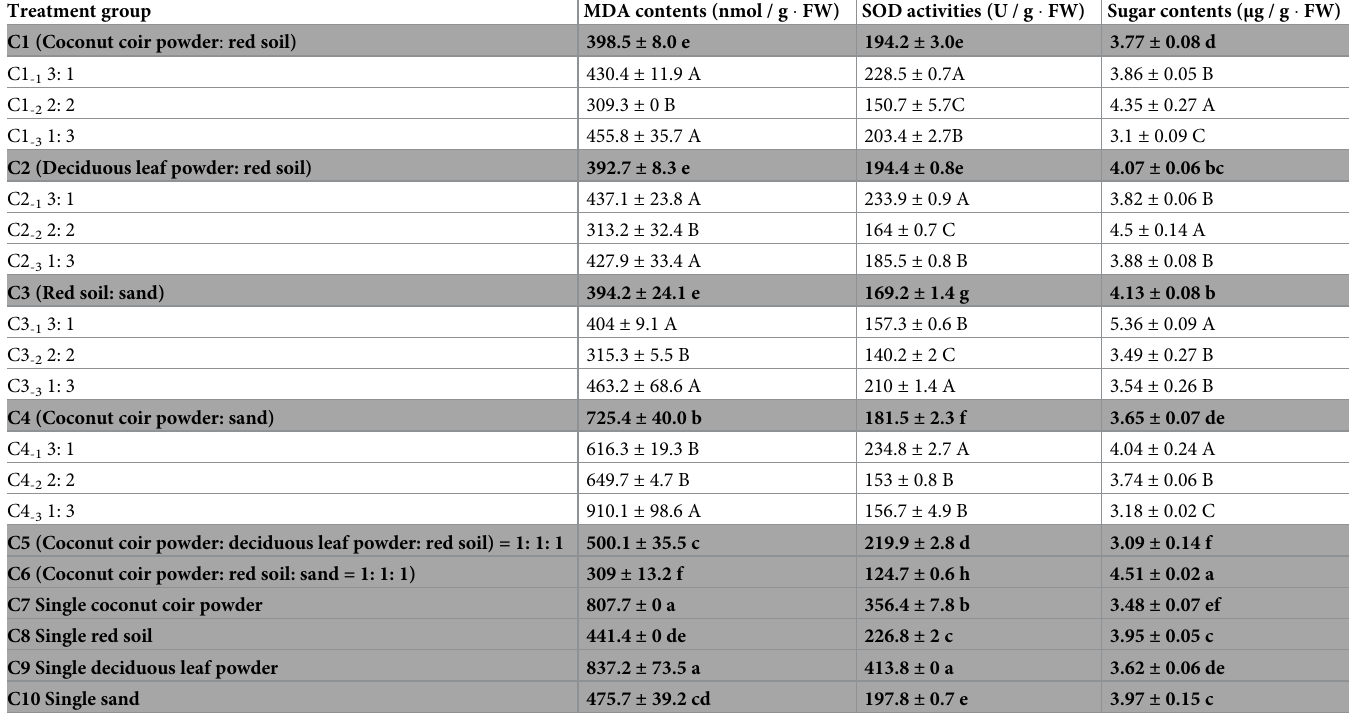
Table 5. Effect of substrate combinations and proportions on malondialdehyde content, superoxide dismutase activity, and sugar content of D . odorifera root sys- tems. Different lowercase letters in the same column indicate the significant difference among different substrate combinations (P < 0.05). Different uppercase letters in the same column indicate the significant difference among the same substrate with different proportions (P < 0.05). Treatment